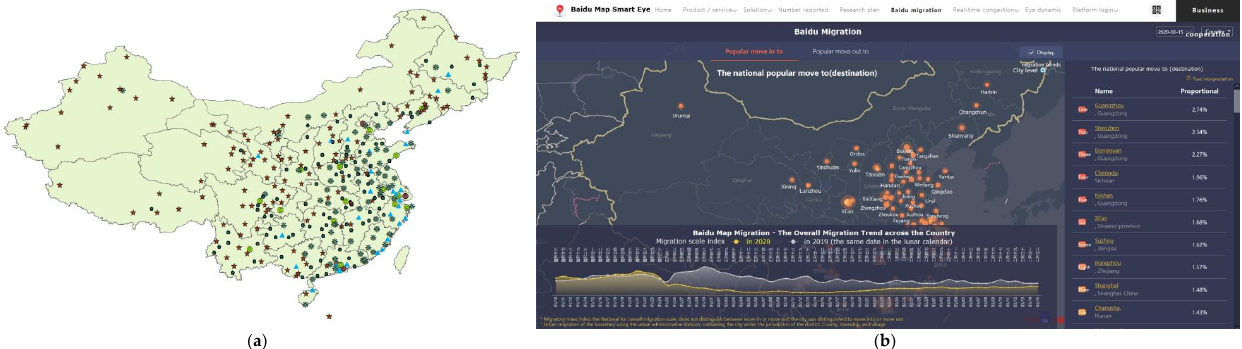
Figure 6. ( a ) A distribution map for the studied POIs (cities) in mainland China; ( b ) a UI that shows inter-city human migration trends at the Baidu Map Smart Eye